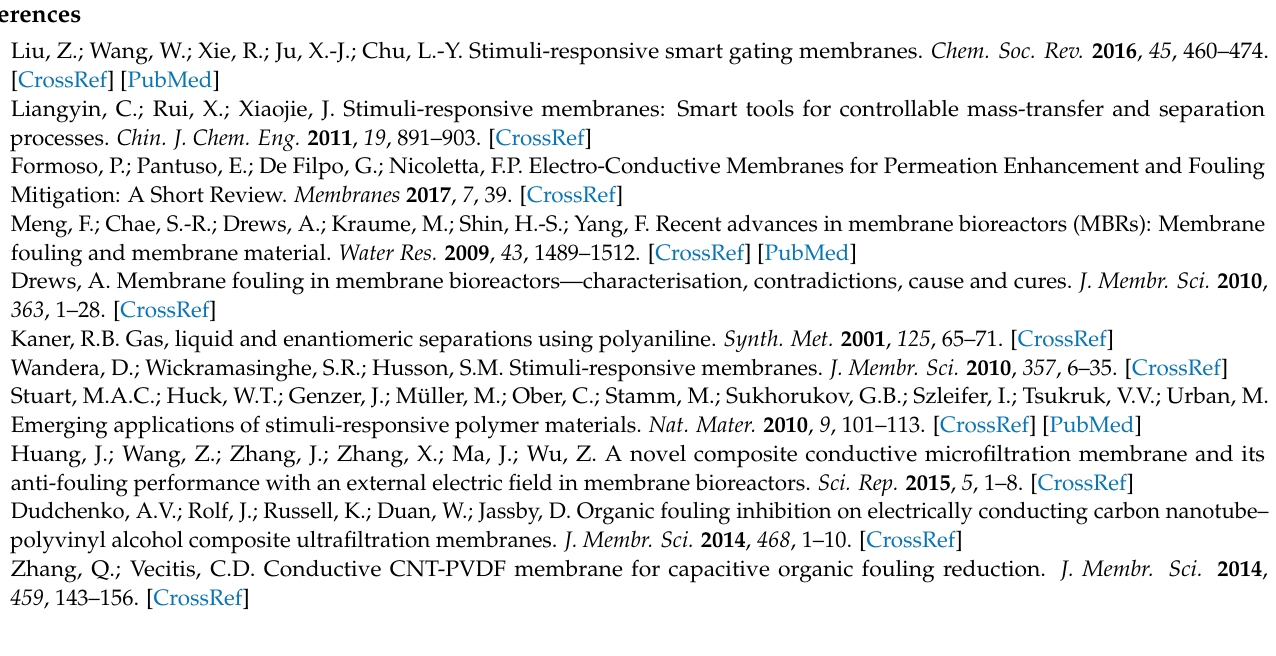
of PANI-PAMPSA complex. Figure S2: Figure S2. The preparation process of PANI/EG composite membrane. Figure S3: The electrically connected membrane assembly in the contact angle goniometer used for electrically connected dynamic droplet penetration analysis as an initial assessment of the electrical tuneable permeation properties of the PANI/EG composite membrane. Figure S4: Setup for evaluating membrane fouling removal. Figure S5: The appearance of the PANI/EG composite membrane produced by NIPS method. Figure S6: The characteristic bands of quinoid and benzenoid rings in the undoped PANI membrane. Figure S7: A series of photos demonstrating the deformation of the PANI/EG composite membrane in response to the applied potential. Figure S8: BSA concentration in the wash solution of PANI/EG composite membranes with